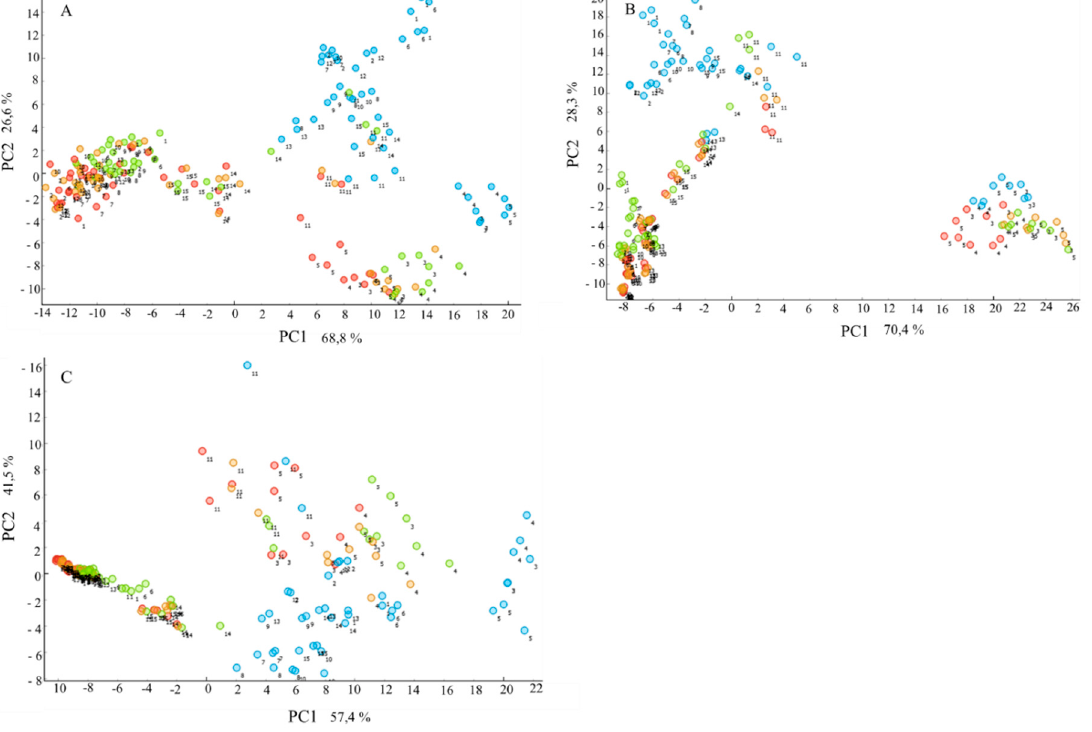
Figure 5. Principal component analysis (PCA) scatter plot of (A) lipid, (B) polysaccharide and (C) protein spectral regions of FTIR spectra of yeasts grown on media with C/N ratios: 10:1 (blue), 40:1 (green), 70:1 (orange) and 100:1 (red). Strains are labelled with numbers according to Table 1.